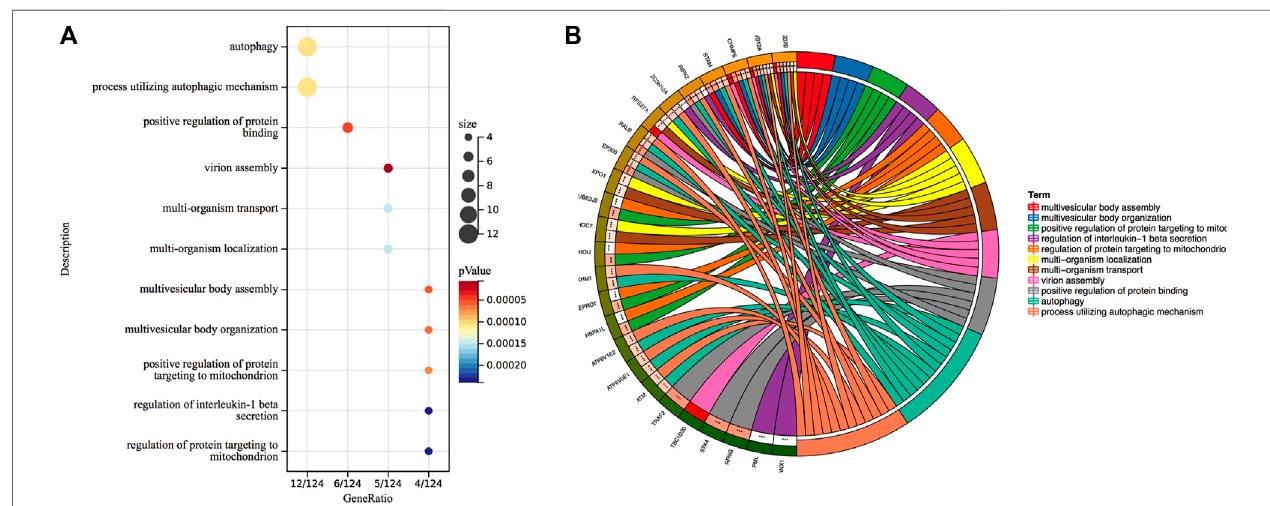
FIGURE 3 | (A) Gene Ontology biological process enrichment analysis of 144 speci fi c DEGs in severe COVID-19. Overall, 11 terms are presented. The size of the circle indicates the relative contribution of the genes to the activity of the term. Colors show the p -value. (B) Circles show genes contained in each term.